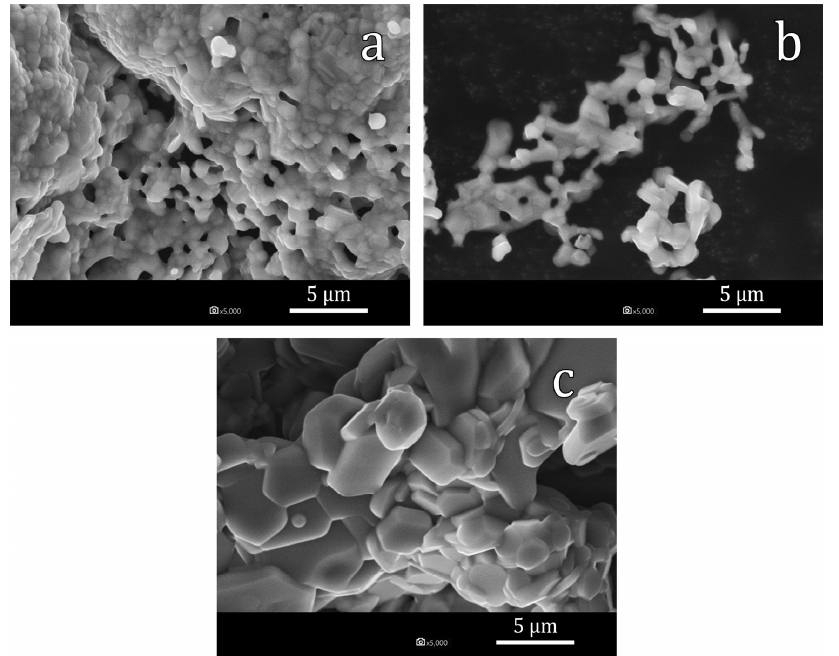
Figure 5. SEM images of SrFe 12 − x In x O 19 particles, where x = 0.5 ( a ), x = 1.0 ( b ), x = 1.7 ( c ), obtained by the citrate method and annealed at 1200 °C for 1 h.